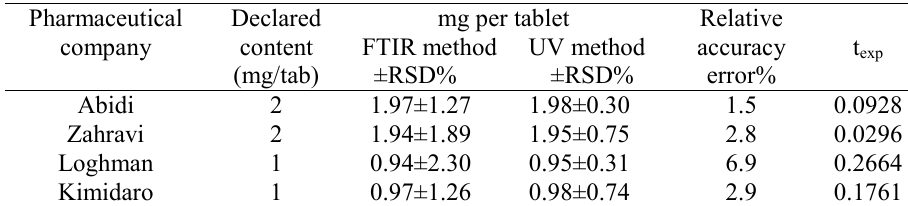
Table 2. Determination of lorazepam in pharmaceuticals by UV and FTIR procedures.